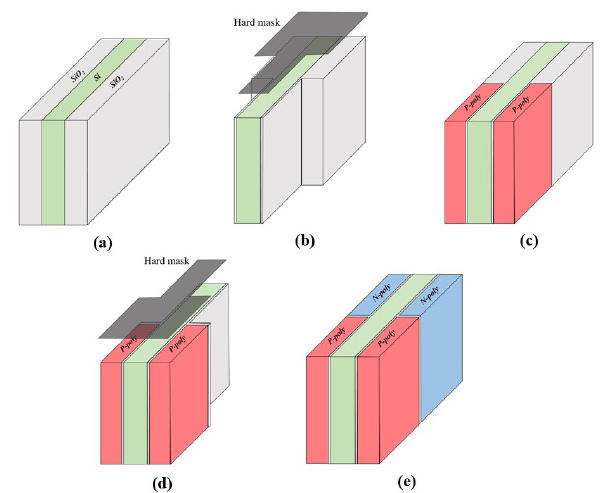
Figure 2. Fabrication process used for the proposed FBFET structure: ( a ) channel and gate oxide re- gion formation , ( b ) double P-poly gate patterning using hard mask, ( c ) double P-poly gate deposition, ( d ) double N-poly gate patterning using hard mask, ( e ) double N-poly gate